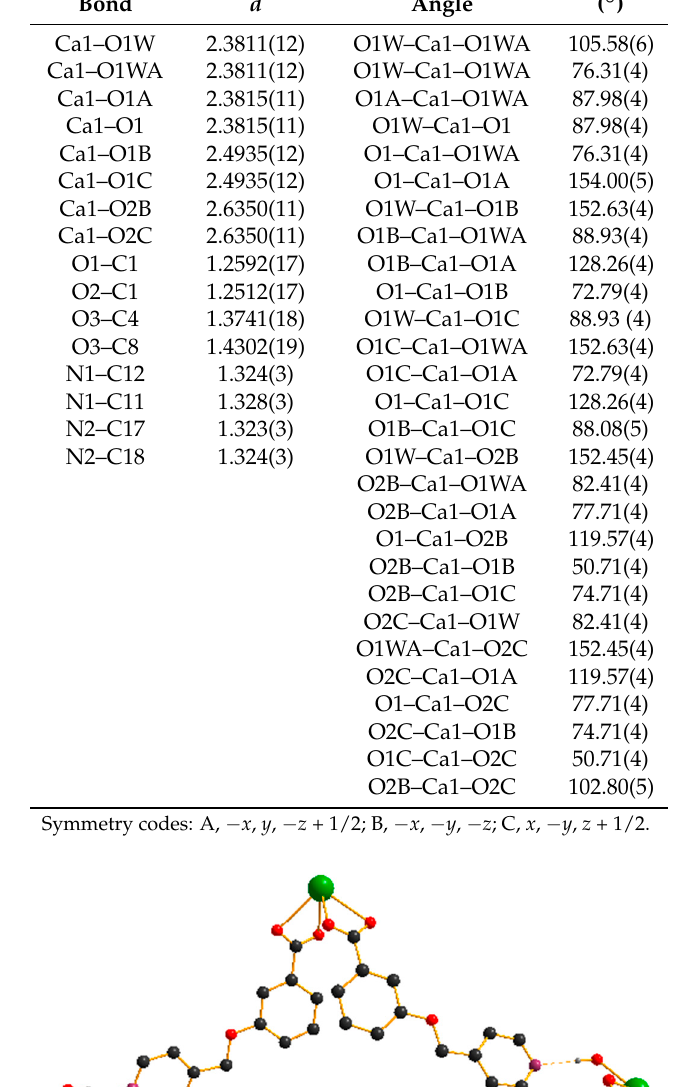
Table 1. Selected bond lengths d (Å) and bond angles ( ◦ ) for [CaL 2 (H 2 O) 2 ] n .